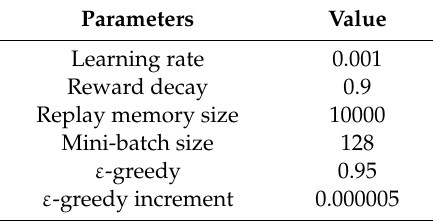
Table 1. Dueling DQN parameters.